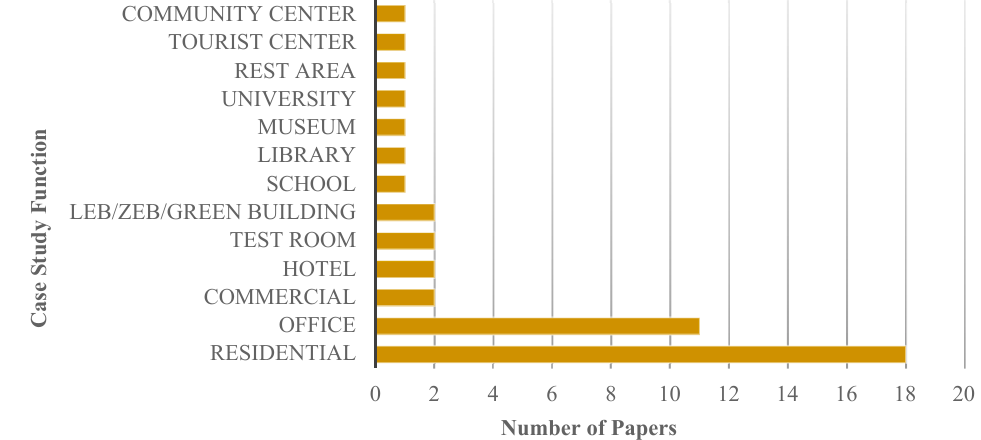
Figure 11. Different functions which have been considered as the case studies in the core literature in addition to the number of papers in which each one has been studied.